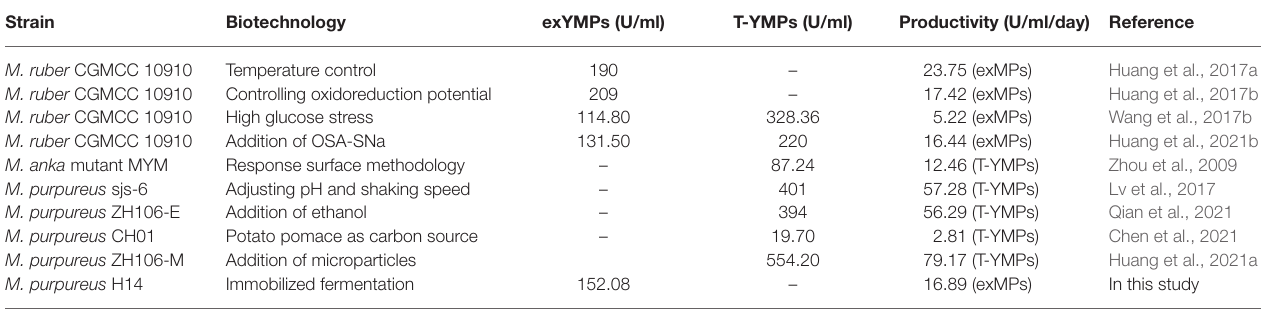
TABLE 4 | Comparison of the production and productivity of yellow monascus pigments by Monascus strains in submerged fermentation.